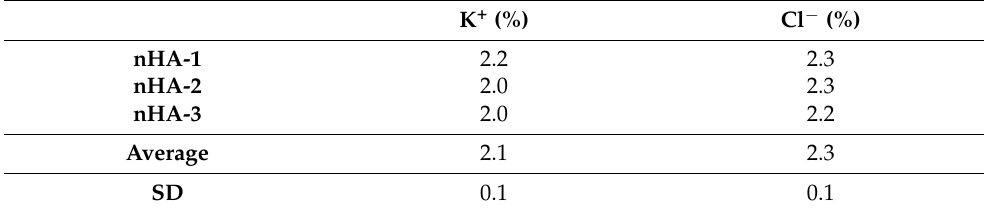
Table 1. Potassium and chloride quantification for the samples nHA-1, -2 and